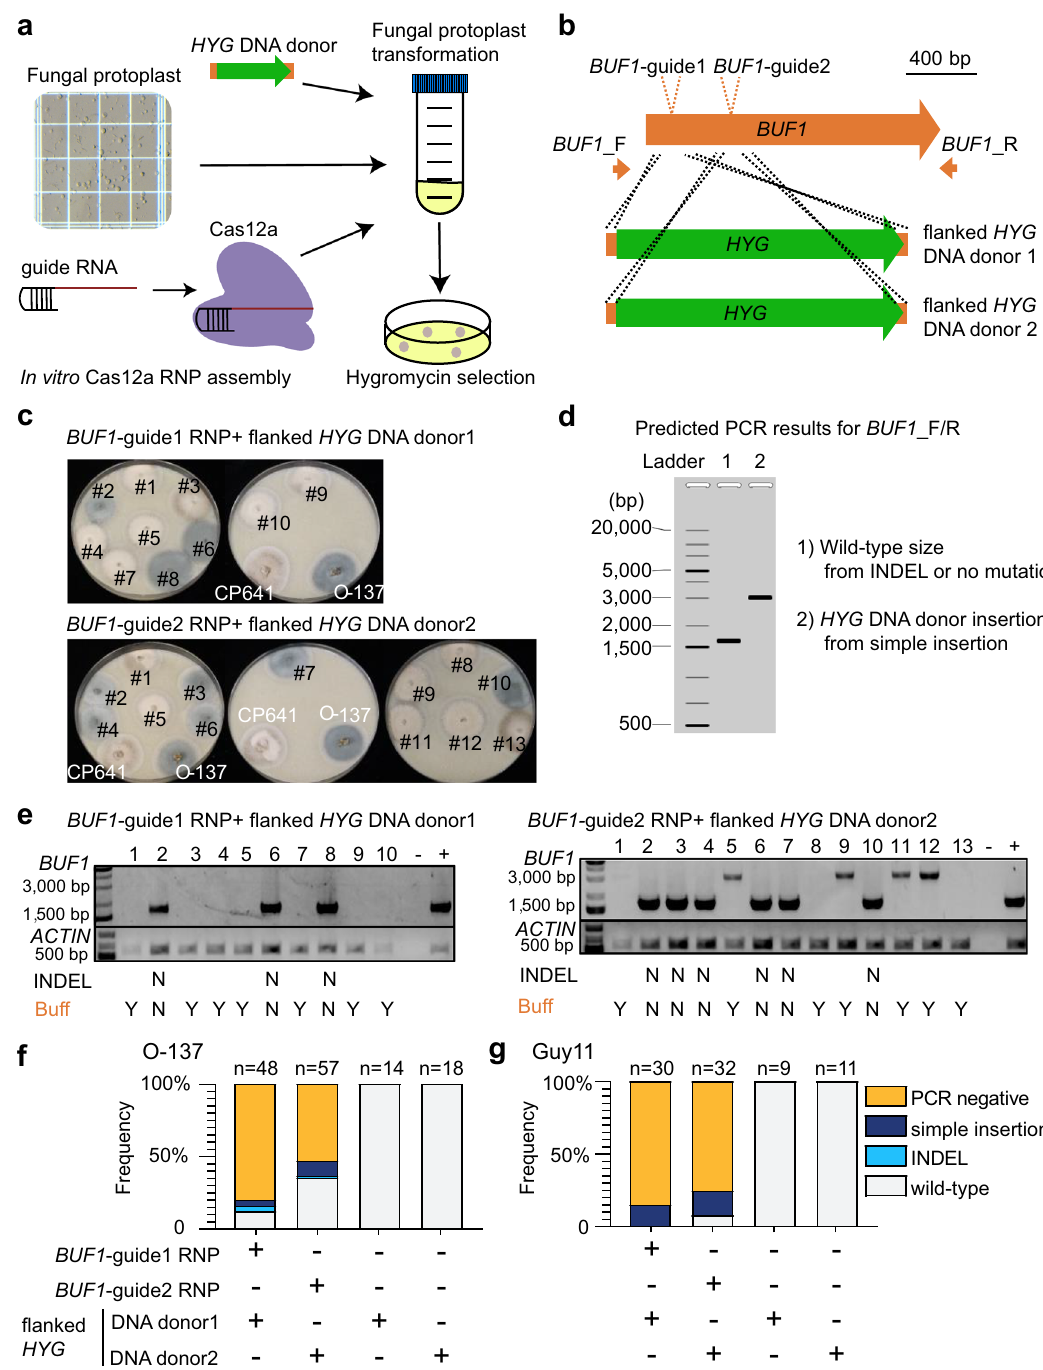
Fig. 1 | Cas12a RNP mediated editing results in unexpected genotyping at the BUF1 locus.a SchematicdiagramofCRISPR-Cas12aRNPmediatedgenomeediting through protoplast transformation in M. oryzae . b Illustration of two BUF1 (MGG_02252, 70-15 MG8 annotation) gRNAs design. Green rectangles indicate two different HYG DNA donors with fl anked sequence homologous to the BUF1 locus shown in orange. The location of PCR primer pair used for genotyping is shown ( BUF1- F/R). c Phenotypes of hygromycin resistant (HYG R ) transformants plated on OTA. The wild-type O-137 is shown (dark grey hyphae) and a previously char- acterized Δ buf1 in O-137 (CP641) showing the buff phenotype. Individual trans- formed colonies showing wild-type and buff color hyphae are shown labeled with numbers. d Diagram of expected results following PCR ampli fi cation from trans- formants.Ladderindicatesthemolecularweightladdertodetermineproductsize, lane 1 (1) shows the expected size product for wild-type or small INDEL BUF1 ampli fi cation,andlane2(2)showstheexpectedsizeproductfor BUF1 ampli fi cation